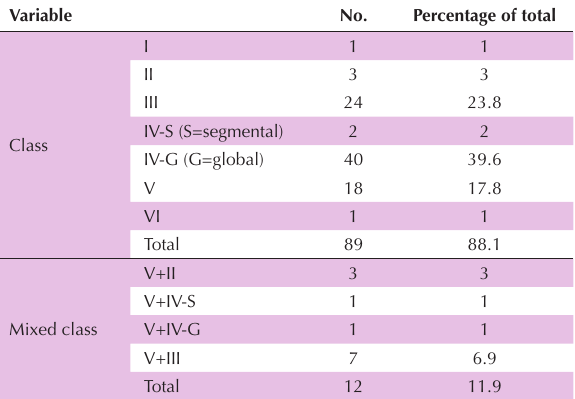
Table 1. Frequency of different lupus nephritis classifications Variable